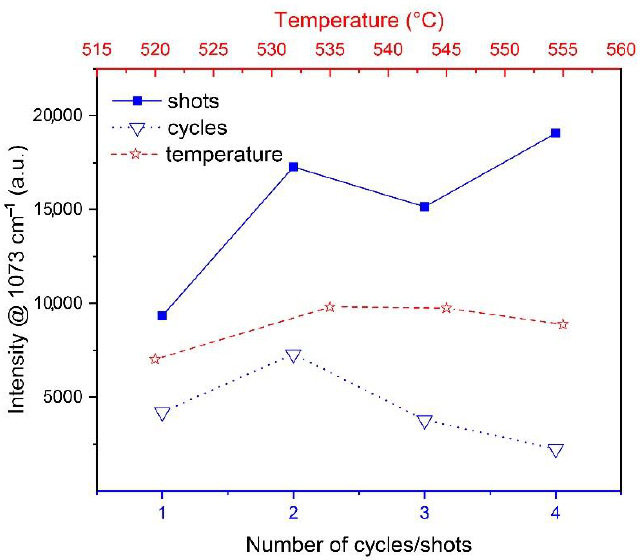
Figure 7. SERS intensity values of MPBA band at 1073 cm − 1 for various cycles, shot numbers and temperatures.